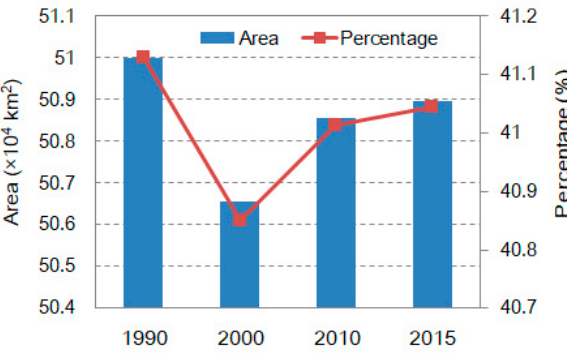
Figure 3. Changes of forest areas and percentage in northeast China from 1990 to 2015.